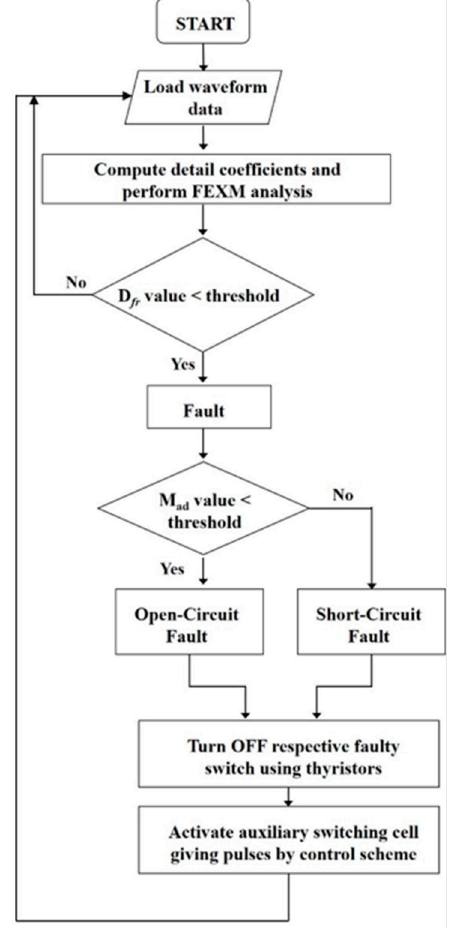
Figure 6. Flow chart of the fault reconfiguration